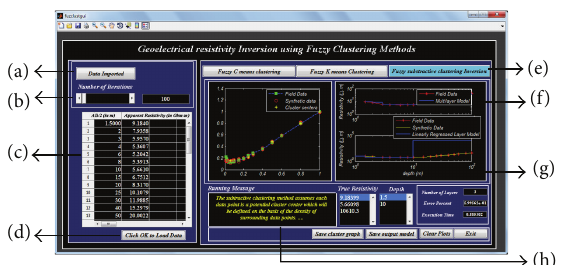
Figure 3: GUI panel showing the fuzzy subtractive clustering inversion for data 1.